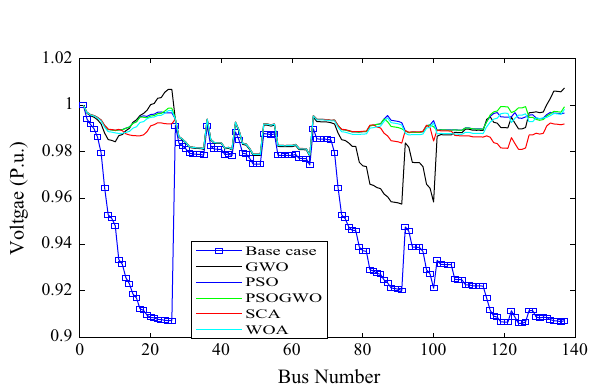
Figure 11. Branch power loss considering different algorithms.